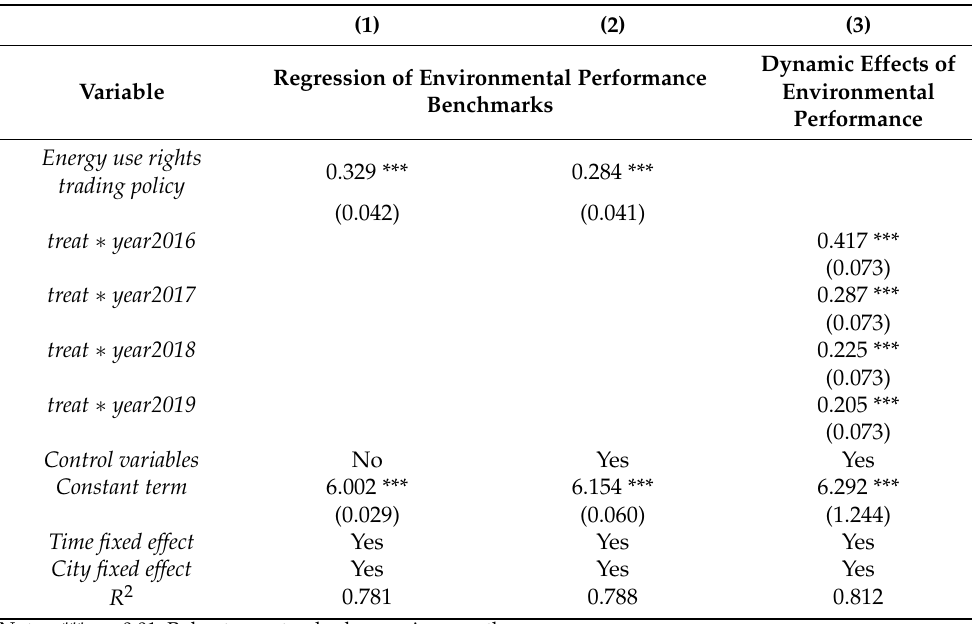
Table 2. Energy trading policy and environmental performance: Regression results of DID